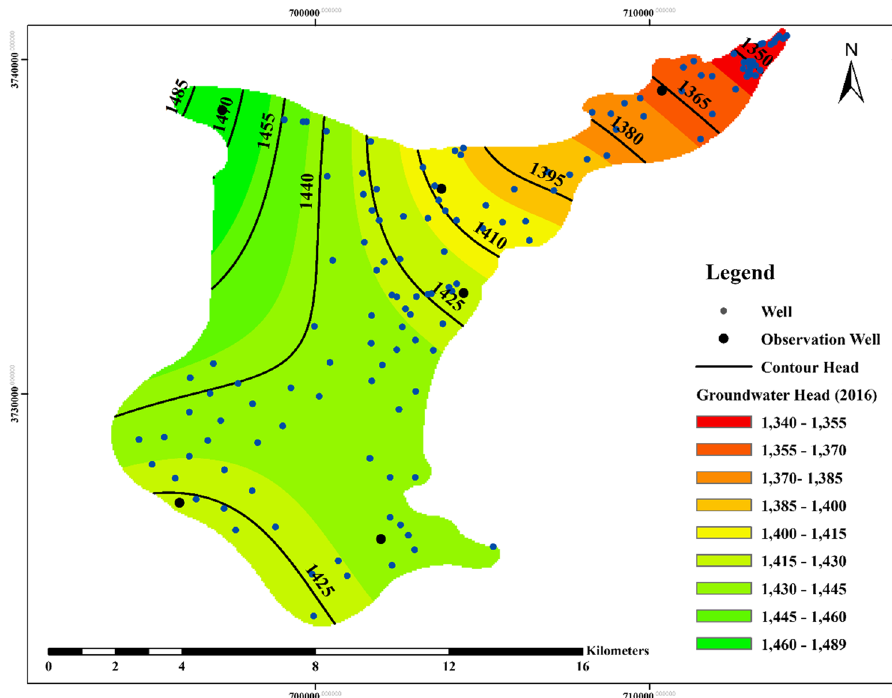
Fig. 11 Groundwater head con- tour lines using spline